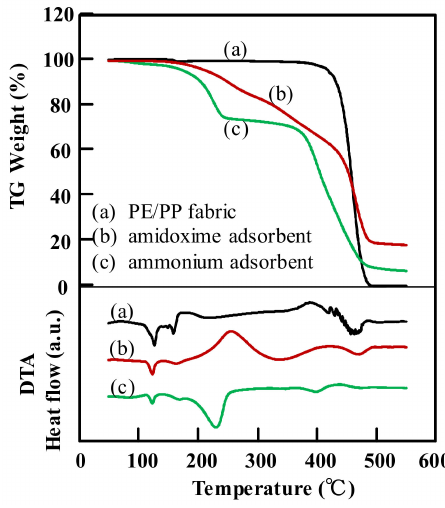
Figure 5. TG/DTA analysis for (a) the PE/PP nonwoven fabric; (b) the amidoxime adsorbent with a density of functional groups of 4.53 mmol/g; and (c) the ammonium adsorbent with a density of functional groups of 3.51